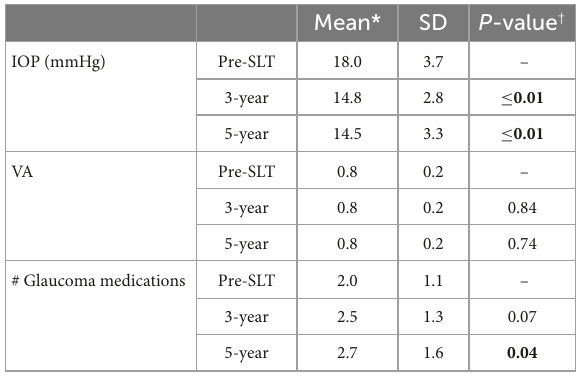
TABLE 4 Outcome measures in eyes that did not receive subsequent surgical